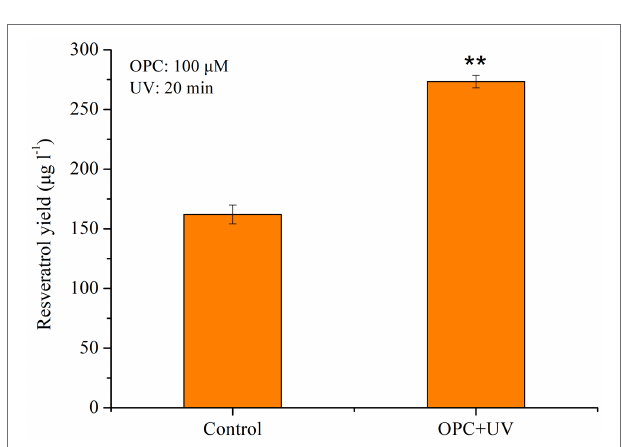
FIGURE 8 | Effect of OPC combined with UV on the resveratrol production, ** p <